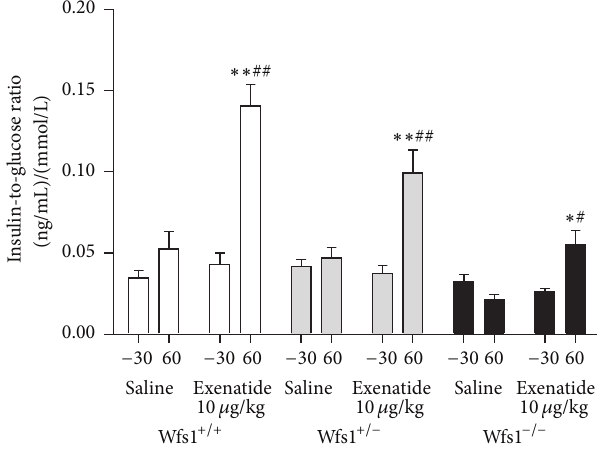
Figure 5: Effect of treatment with exenatide during IPGGT on insulin levels. Wfs1 +/+ , white bars; Wfs1 +/− , grey bars; Wfs1 −/− black bars. To compare the insulin levels between baseline ( − 30min) and the 60-minute time point, repeated measures ANOVA was used. 𝑛 = 8 in all groups.